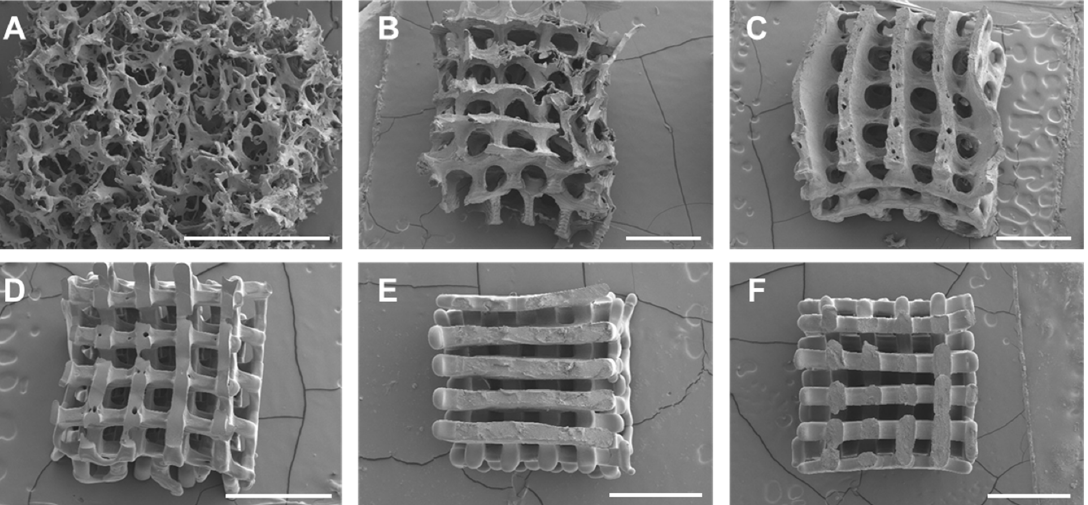
Figure 5. SEM images of ( A ) salt-leached, ( B ) 10% aqueous, ( C ) 20% aqueous, ( D ) 10% HFIP-based, ( E ) 20% HFIP-based, and ( F ) 30% HFIP-based SF scaffolds. The pore size, shape, and geometry of the aqueous and HFIP-based SF scaffolds fabricated via 3D-printed molds were relatively well controlled whereas the salt-leached scaffolds exhibited non-uniform pore size and shape (scale bar: 1 mm).